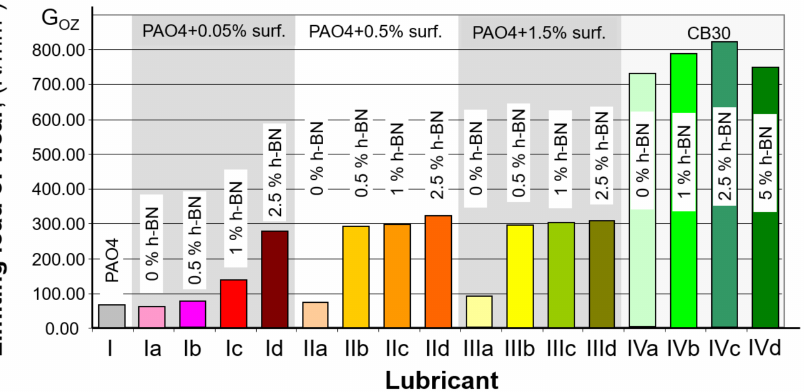
Figure 6. Limit wear load G OZ as a function of base oil used and h-BN and surfactant